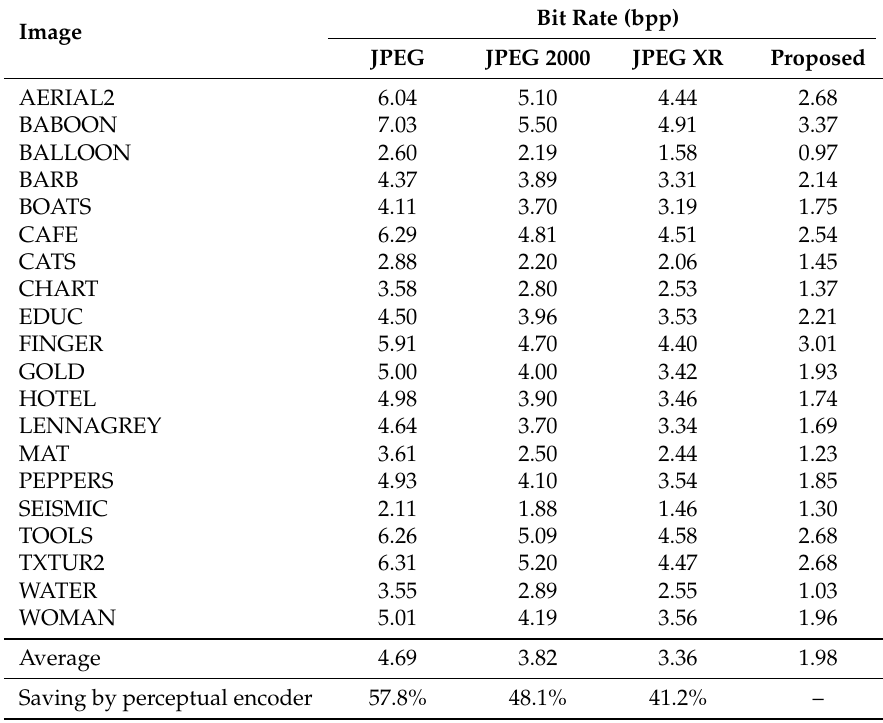
Table 7. Compressed data rates of JPEG, JPEG 2000, JPEG XR and the proposed JND-based